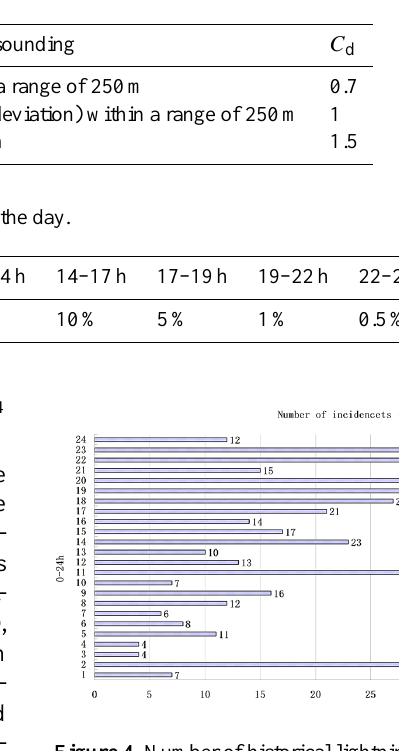
Figure 4. Number of historical lightning incidents occurring hourly in